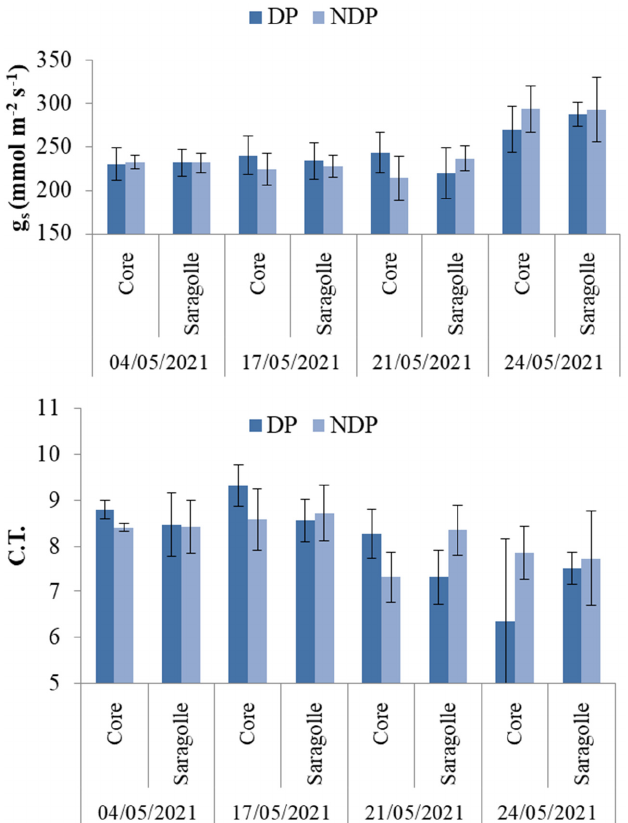
Figure 4. Bar plots of the mean values overlaid by standard deviation bars of stomatal conductance (g s ) (mmol m − 2 s − 1 ) ( top ) and the ratio between g s and temperature (C.T.) ( bottom ) at different dates during the reproductive stage in clipped (DP) (dark blue columns) and unclipped (NDP) (light blue columns) treatments in Core and Saragolle varieties. g s never decreased below 200 mmol m − 2 s − 1 indicating that stomatal closure never occurred during the survey (even during hot days with temperatures above the average of the period). Soil water monitoring was carried out from April to June, a period corre- sponding to the phenological transition from booting to grain filling.